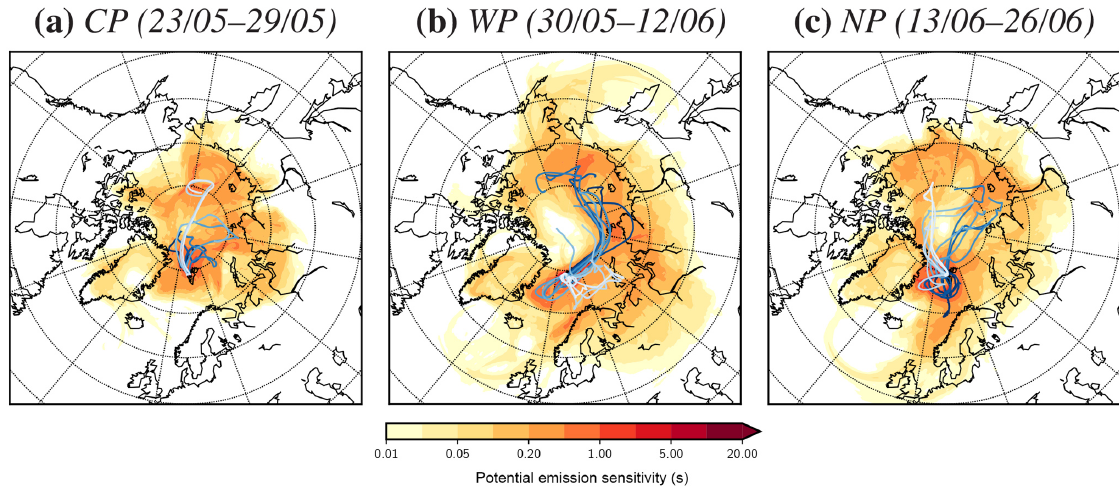
Figure 7. Ranges of continuous daily potential emission sensitivities (shading) and daily center of mass backward trajectories to Ny-Ålesund, with later masses in brighter colors (trajectories) for each ACLOUD/PASCAL key period from FLEXPART. The key periods are defined as (a) the cold period (CP), (b) the warm period (WP), and (c) the normal period